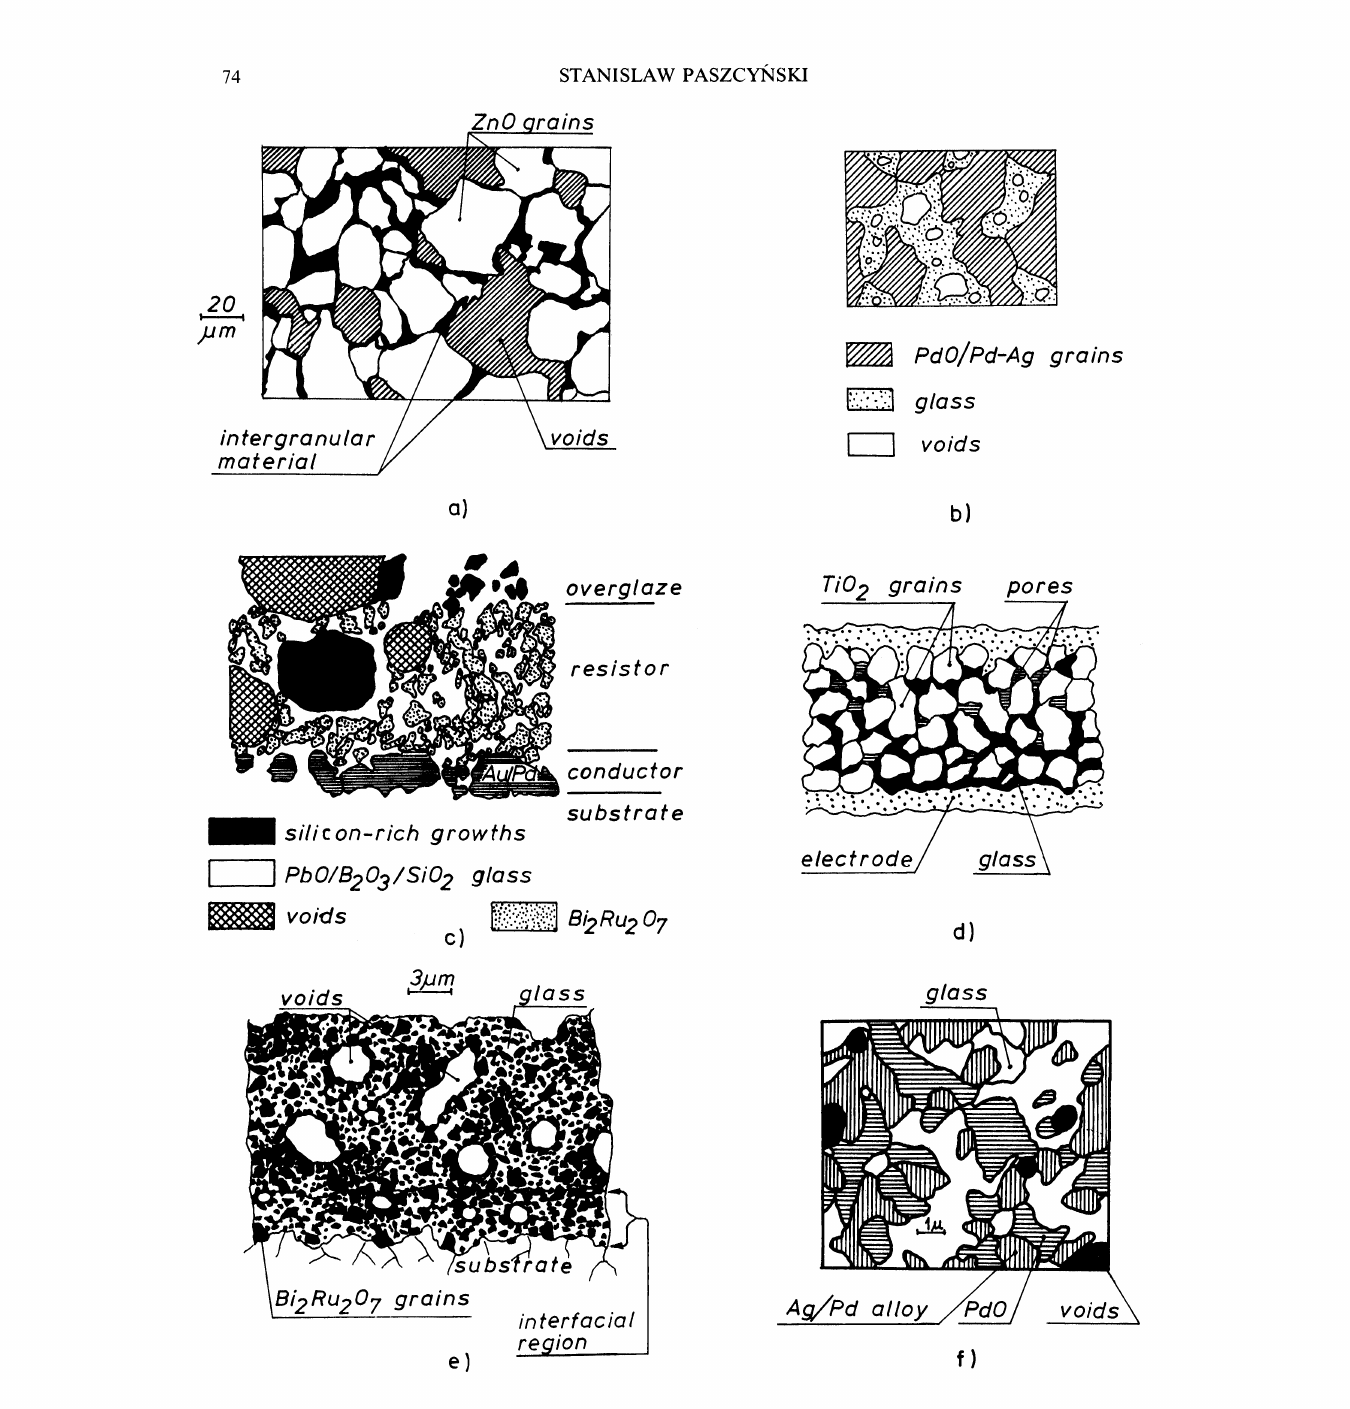
Schematic distribution of the major constituent media in some thick film structures:- (a) in varistor film, (b) in resistive film, PdO/Pd-Ag type? (c) across conductor resistor overglaze interfaces in Du Pont 1100 type, (d) in dielectric film, 6,17 (e) in resistive ruthenate film, (f) in resistive film Pd-Ag Du Pont7800